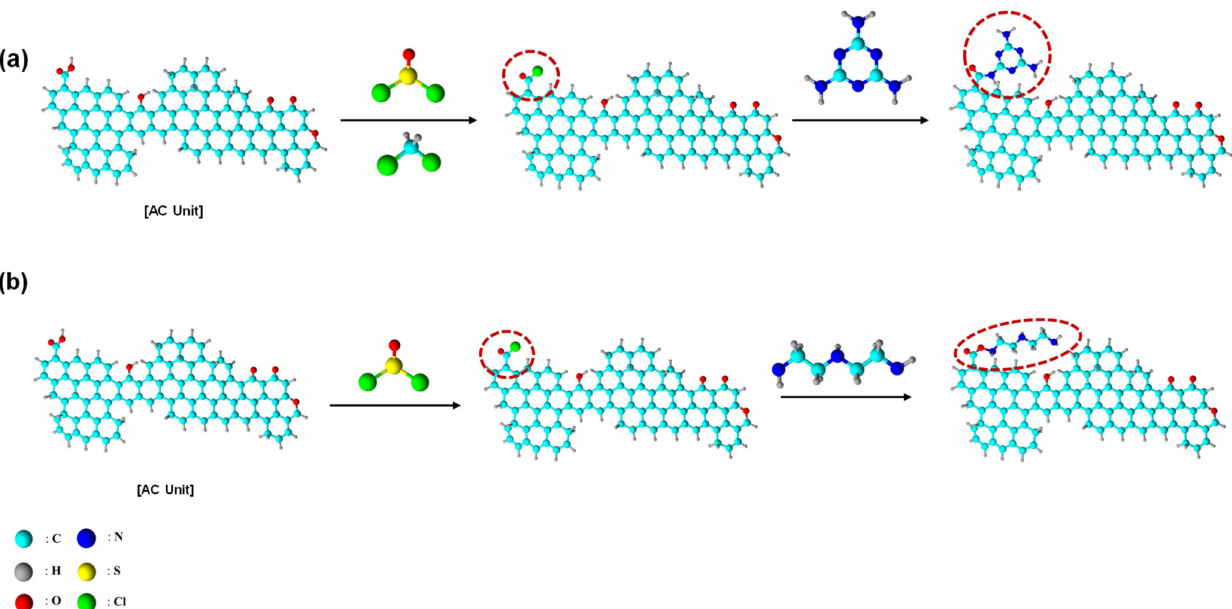
Figure 3. Grafting reactions ( a ) between melamine and activated carbon and ( b ) between diethylene triamine and activated carbon via halogenated intermediates for both